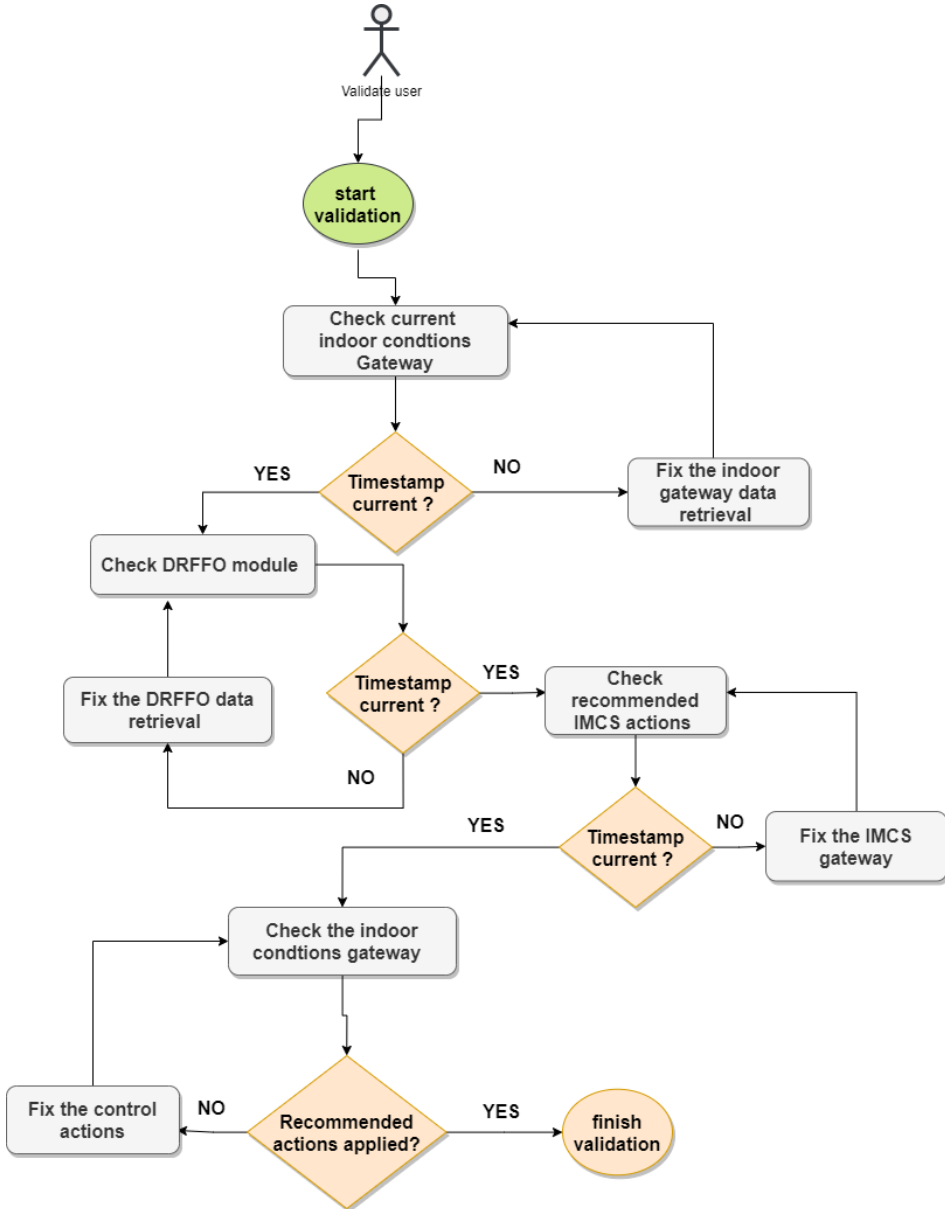
Figure 14. Flow chart to validate the the IMCS procedure is operating